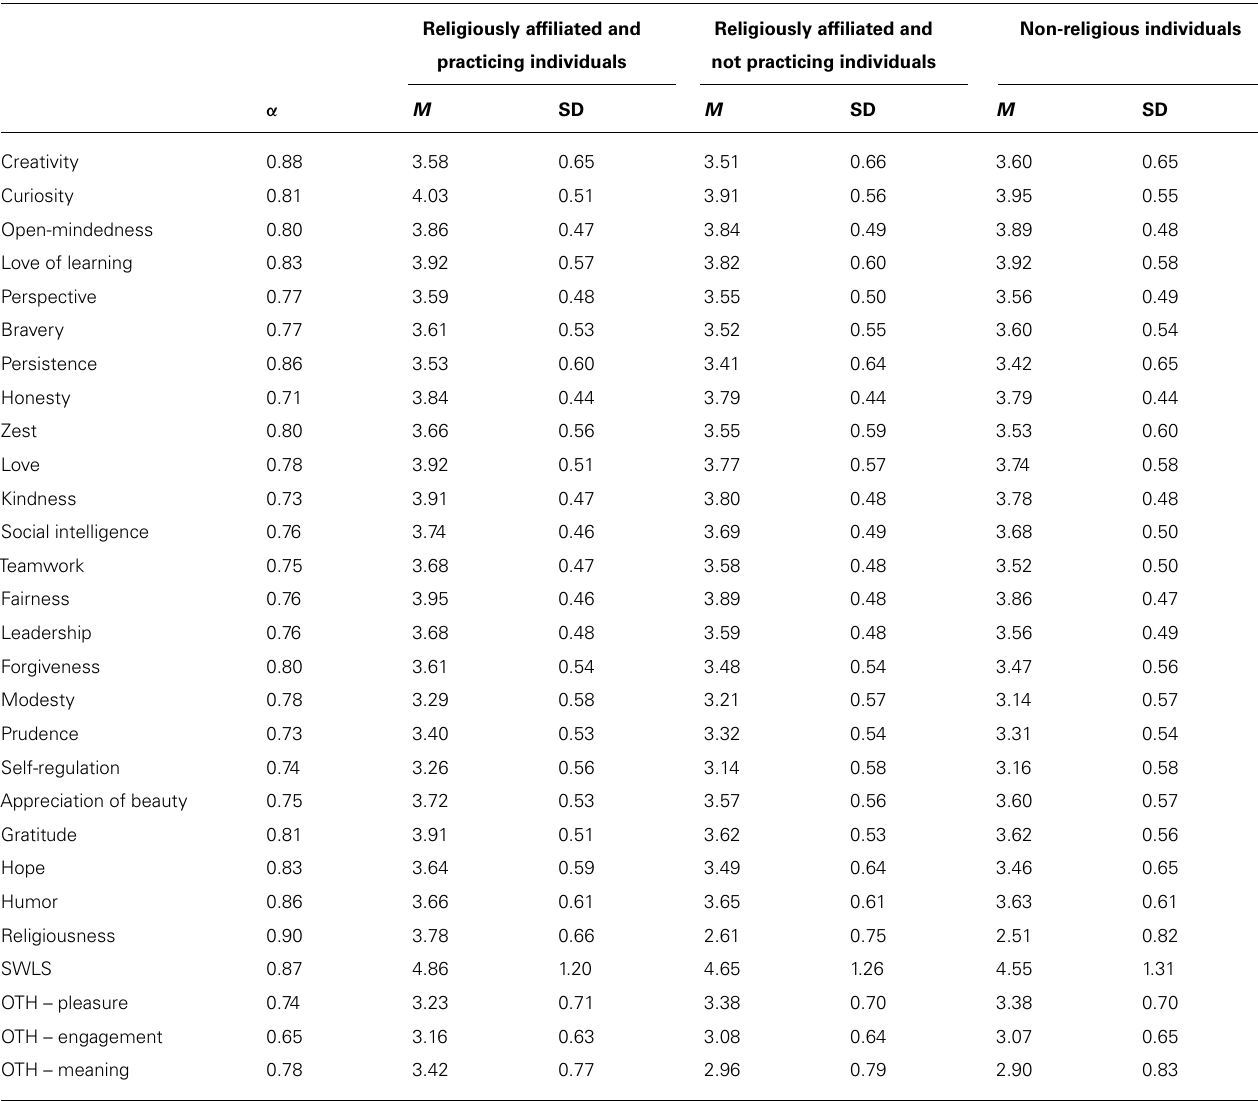
Table 1 | Reliabilities of theVIA-IS-scales, SWLS, OTH, and descriptive statistics of the three groups.